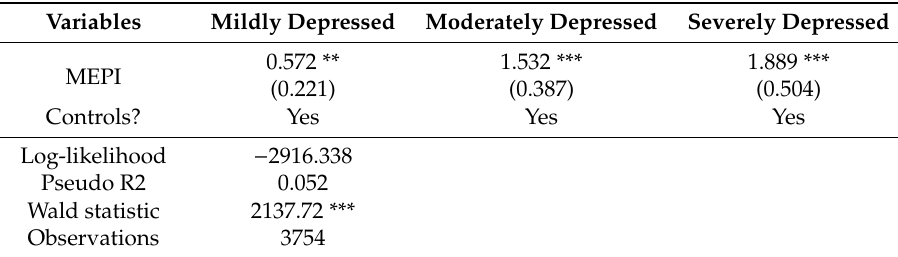
Table A3. E ff ect of MEPI on depression from the pooled multinomial